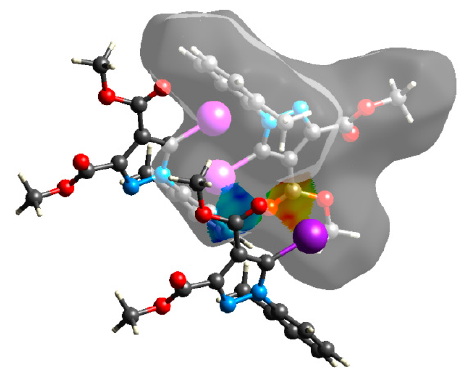
Figure 19. Shape index Hirshfeld surface of compound 1 with the complementary surfaces indicating a possible π –hole interaction [35].